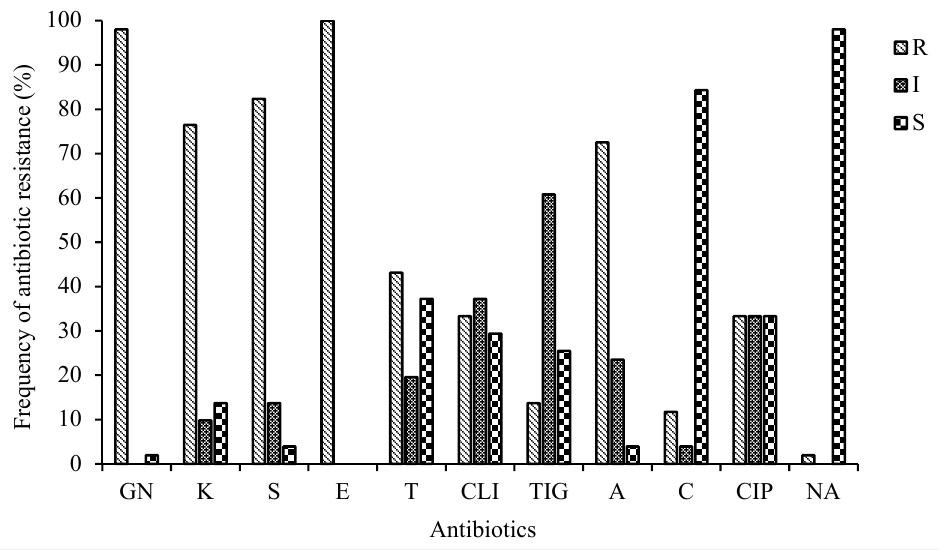
Figure 1. Antibiotic resistance profile of STEC isolates; GN: Gentamicin, K: Kanamycin, S: Streptomycin, E: Erythromycin, T: Tetracycline, CLI: Clindamycin, TIG: Tigecycline, A: Ampicillin, C: Chloramphenicol, CIP: Ciprofloxacin, NA: Nalidixic acid. Table 3. Pattern of distribution of antibiotic resistance in STEC isolates; GN: Gentamicin, K: Kanamycin, S: Streptomycin, E: Erythromycin, T: Tetracycline, CLI: Clindamycin, TIG: Tigecycline, A: Ampicillin, C: Chloramphenicol, CIP: Ciprofloxacin, NA: Nalidixic